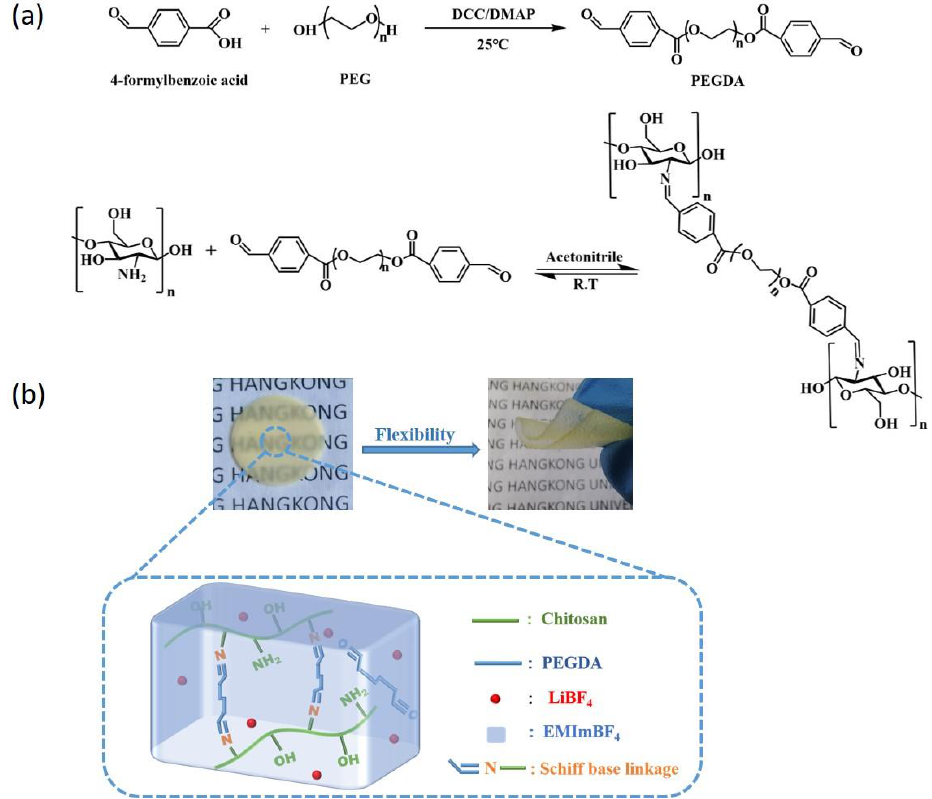
Figure 1. ( a ) Synthetic route of PEGDA and the cross−linked polymer, ( b ) schematic illustration and digital photos of the cross−linked MCIGPE film.